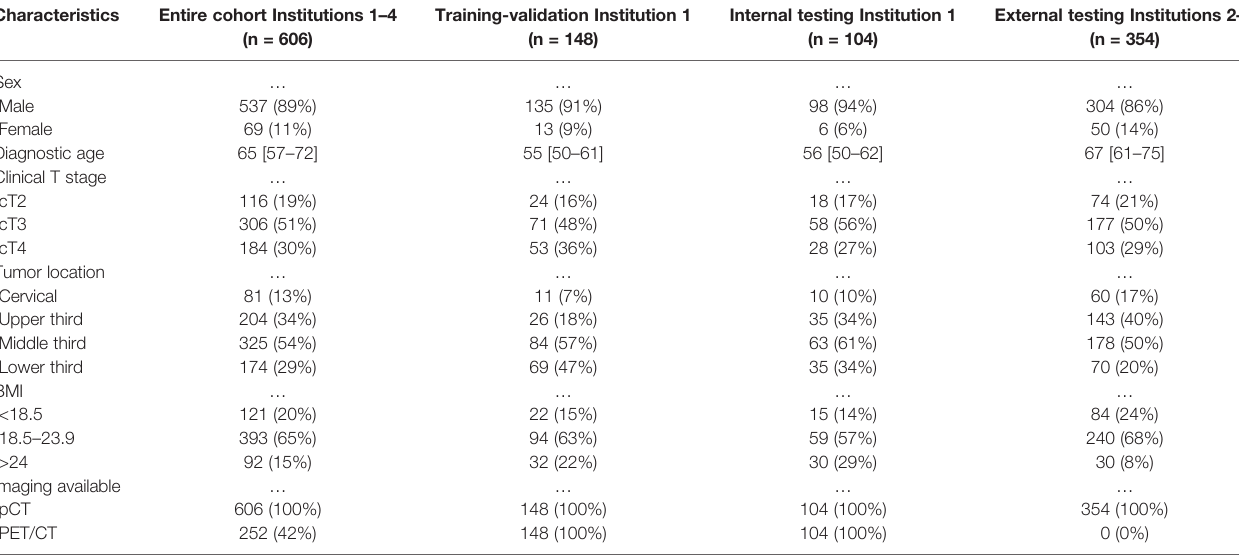
TABLE 1 | Subject and imaging